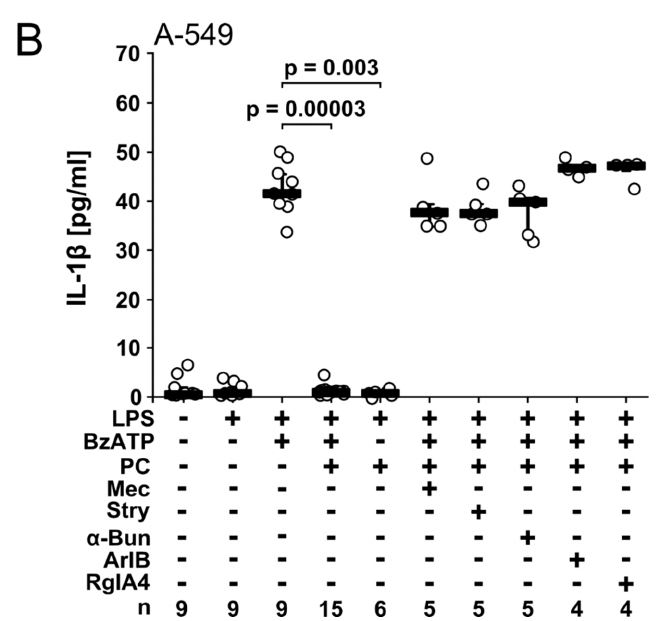
Figure 1. Nicotine (Nic) and phosphocholine (PC) inhibit the release of IL-1 β by A549 cells. Human LPS-primed A549 cells were stimulated with 2 ′ (3 ′ )-O-(4-benzoylbenzoyl)adenosine-5 ′ -triphosphate (BzATP, 100 µ M) in the presence or absence of Nic (100 µ M) ( A ) or PC (100 µ M) ( B ) and the IL-1 β released to the supernatant was measured 30 min later. The inhibitory effects of Nic and PC were sensitive to nicotinic antagonists mecamylamine (Mec; 100 µ M), strychnine (Stry; 10 µ M), α -bungarotoxin ( α -Bun; 1 µ M), [V11L, V16D]ArIB (500 nM), or RgIA4 (200 nM). Data are presented as individual data points, bars represent median, whiskers encompass the 25th to 75th percentile; n-numbers of independent experiments are indicated in the figure. Experimental groups were compared by Kruskal Wallis test followed by Mann Whitney rank sum